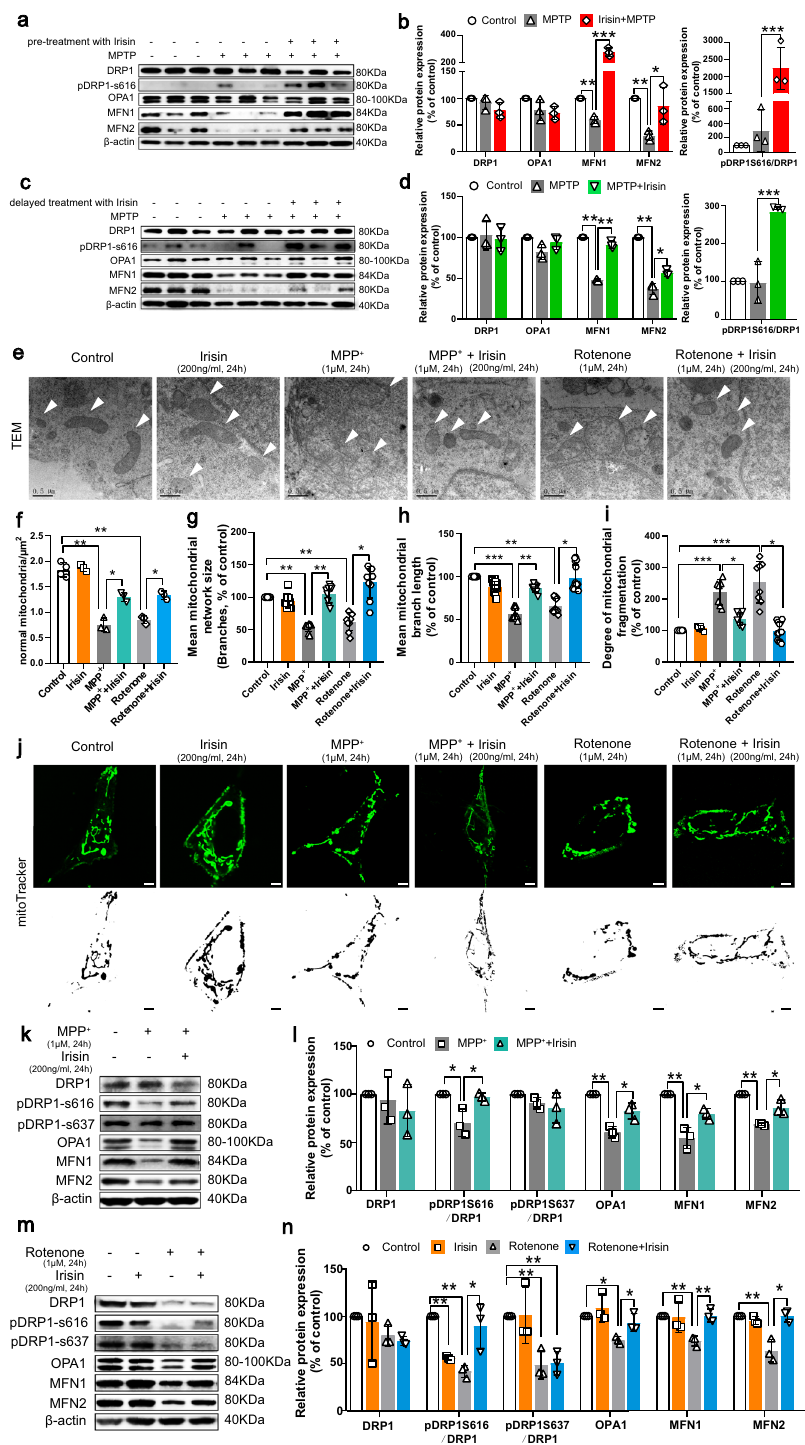
Fig. 5 Irisin regains thwarted mitochondrial fusion and fi ssion and morphology in PD models induced by neurotoxins. a , b Western blot showing the quanti fi cation of DRP1, pDRP1-S616/DRP1 ratio, OPA1, MFN1and MFN2 in each group of MPTP treated mice receiving pre- treatment with irisin. c , d Western blot showing the quanti fi cation of DRP1, pDRP1-S616/DRP1 ratio, OPA1, MFN1and MFN2 in each group of MPTP treated mice receiving delayed treatment with irisin. e , f Transmission electron microscopy image and relative quantitative analysis of SH-SY5H cells showing mitochondrial morphology in various groups of in vitro experiments (magni fi cation 40,000×). Scale bar, 0.5 μ m. g – j mitoTracker fl uorescence staining and its quanti fi cation analysis of mitochondrial fragmentation in various groups of in vitro experiments. Scale bar, 2 μ m. k , l Western blot showing the quanti fi cation of DRP1, pDRP1-S616/DRP1 ratio, pDRP1-S637/DRP1 ratio, OPA1, MFN1and MFN2 in each group of SH-SY5Y cells treated by irisin and MPP + . m , n Western blot showing the quanti fi cation of DRP1, pDRP1-S616/DRP1 ratio, pDRP1-S637/DRP1 ratio, OPA1, MFN1and MFN2 in each group of SH-SY5Y cells treated by irisin and rotenone. All data are presented as mean ± SEM ( n ≥ 3). ∗ p < 0.05, ∗∗ p < 0.01, and ∗∗∗ p <